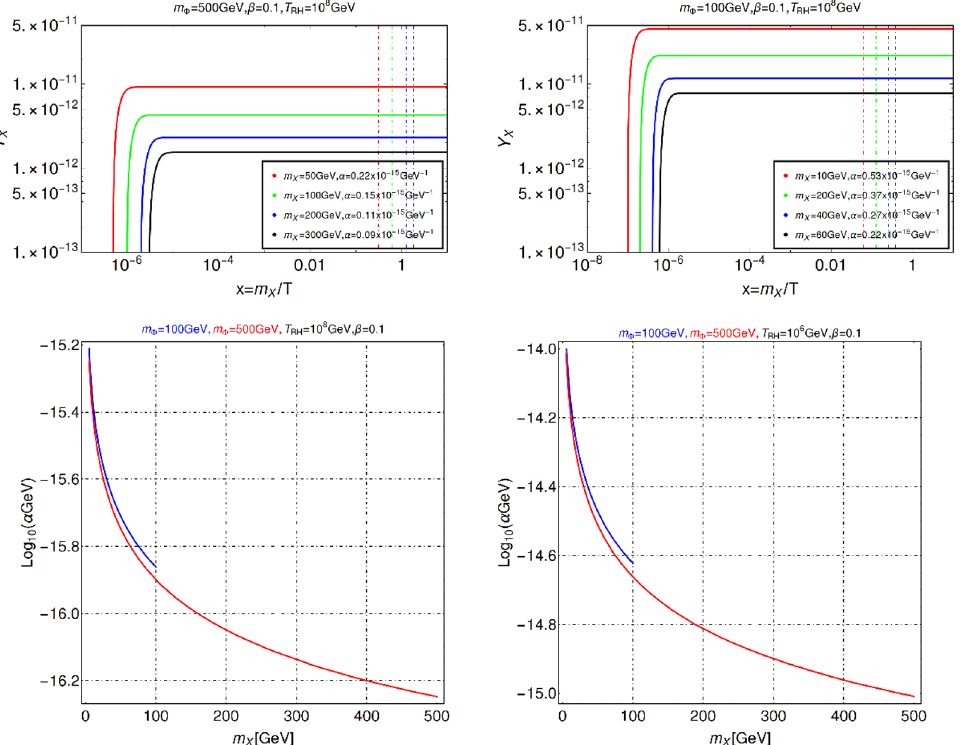
Figure 8 . Top left: evolution of the DM yield Y X for parameters which imply correct relic DM abundance as a function of x = m X /T obtained by solving eq. (4.1). Here different colored curves indicate different choices of r = m X = { 0 . 1 , 0 . 2 , 0 . 4 , 0 . 6 } in red, green, blue and black respectively m Φ for a fixed m Φ = 100 GeV , α = 10 − 16 GeV − 1 , β = 0 . 1 and reheat temperature T RH = 10 8 GeV . The vertical dashed-dotted lines correspond to x EW = m X /T EW for different values of m X . Top right: same as top left but with m Φ = 500 GeV . Bottom left: relic density allowed parameter space in terms of m X − α where different colored contours correspond to m Φ = 500 GeV (red) and m Φ = 100 GeV (blue) for a fixed β = ˜ α = 0 . 1 and reheat temperature T RH = 10 8 GeV . Bottom α right: same as bottom left but with T RH = 10 6 GeV